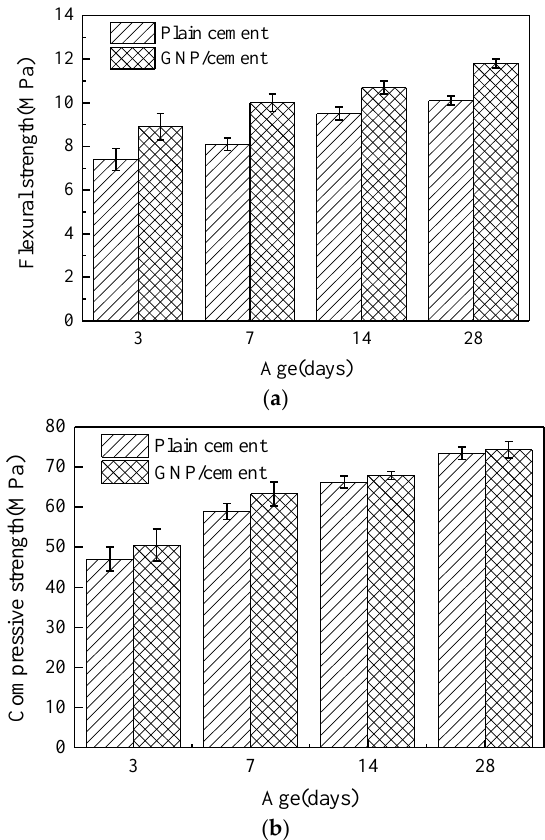
Figure 4. Mechanical properties of plain cement and GNP-cement composite at various ages. ( a ) Flexural strength of plain cement and GNP-cement composite at various ages. ( b ) Compressive strength of plain cement and GNP-cement composite at various ages.